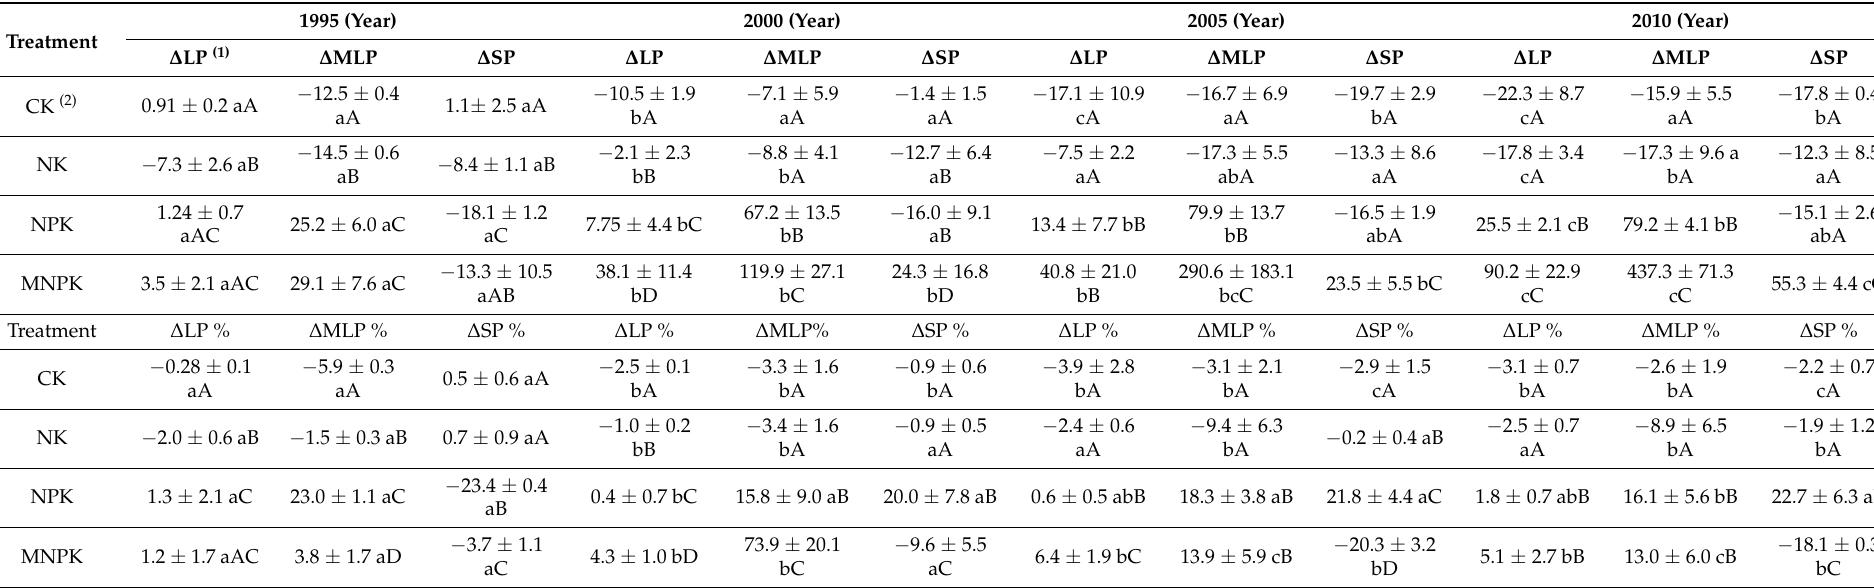
Table 4. Increase amount and percentage of P fractions at the two long-term experiments (mg kg − 1 ).